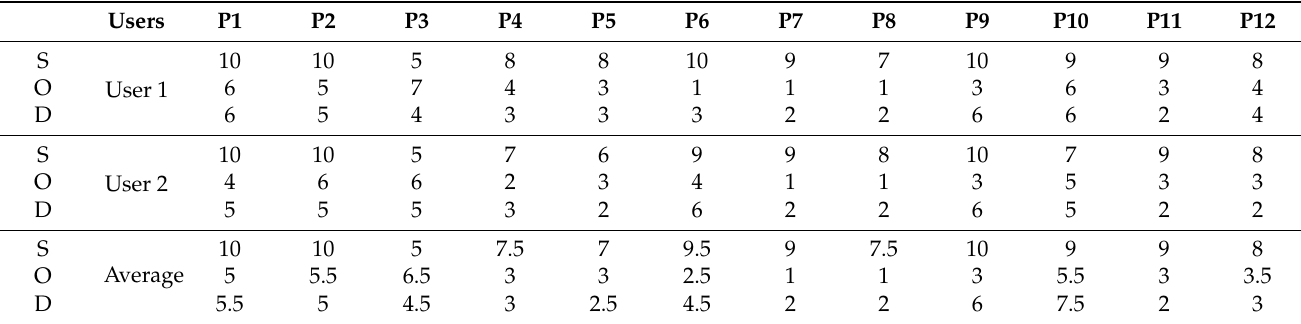
Table 6. Input data of two different cases in smartphones.